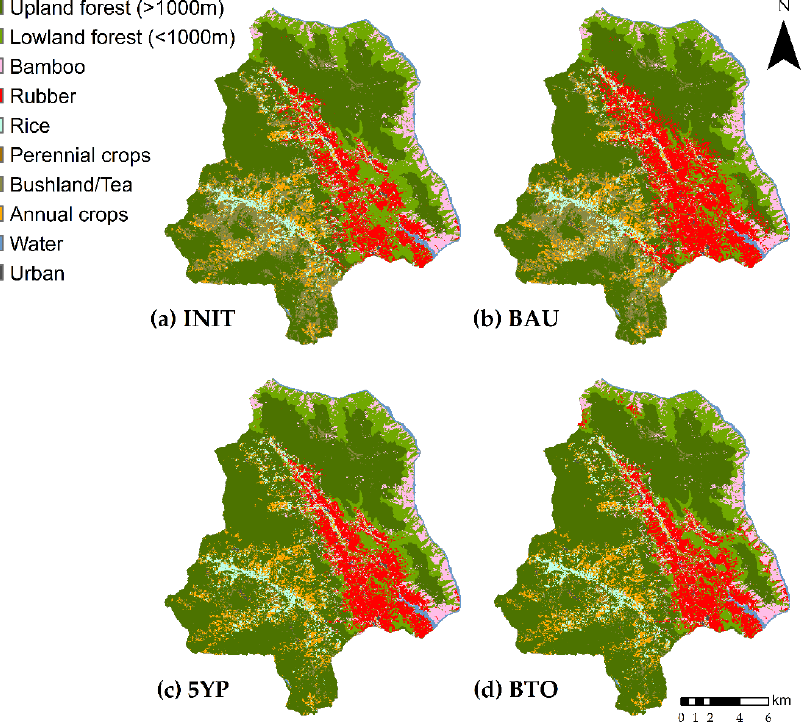
Figure 2. Land use maps of Nabanhe Reserve; the initial condition in 2015 ( a ), the Business-As-Usual Scenario in 2040 ( b ), based on linear extrapolation of past rubber expansion rates, the 5-Years-Plan scenario in 2040 ( c ), based on province-level policy land use guidelines, and the Balanced-Trade-Offs scenario in 2040 ( d ), based on the 5-Years-Plan and additional measures such as water protection zones and riparian buffer zones. Maps are taken from Thellmann et al. [61].